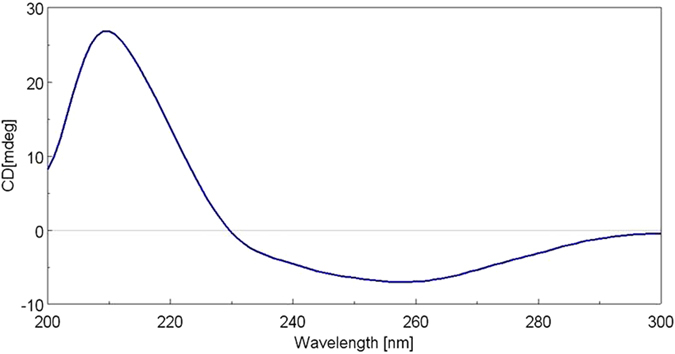
CD spectrum (1.2 × 10−4 M, MeOH) of 2.